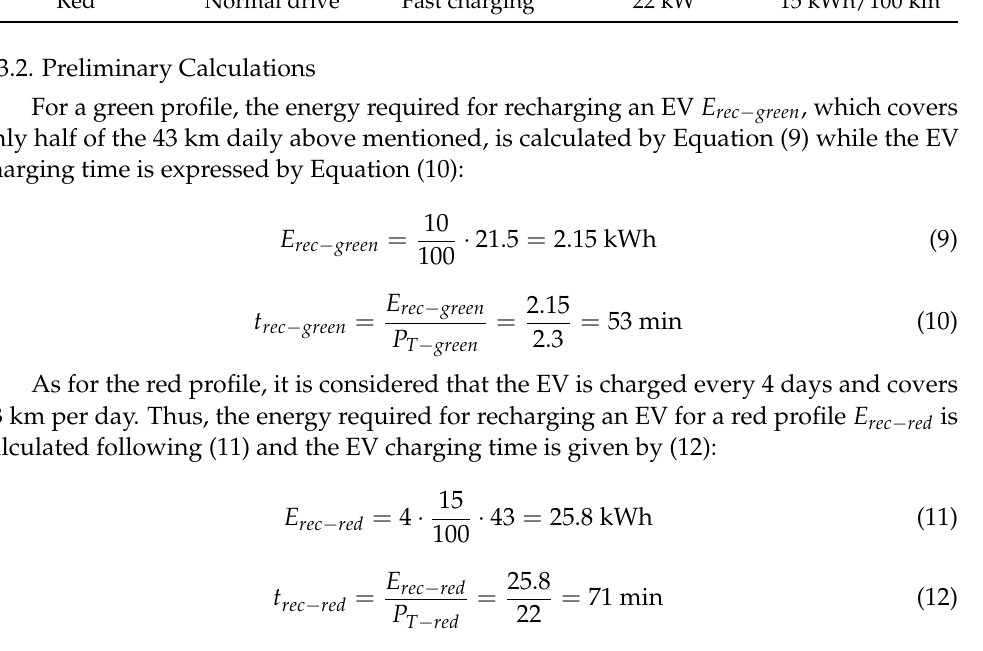
Table 5. User profiles of the PVCS. Profile Drive Mode Charging Type Green Eco-drive Slow charging 2.3 kW Red Normal drive Fast charging 22 kW 15 kWh/100